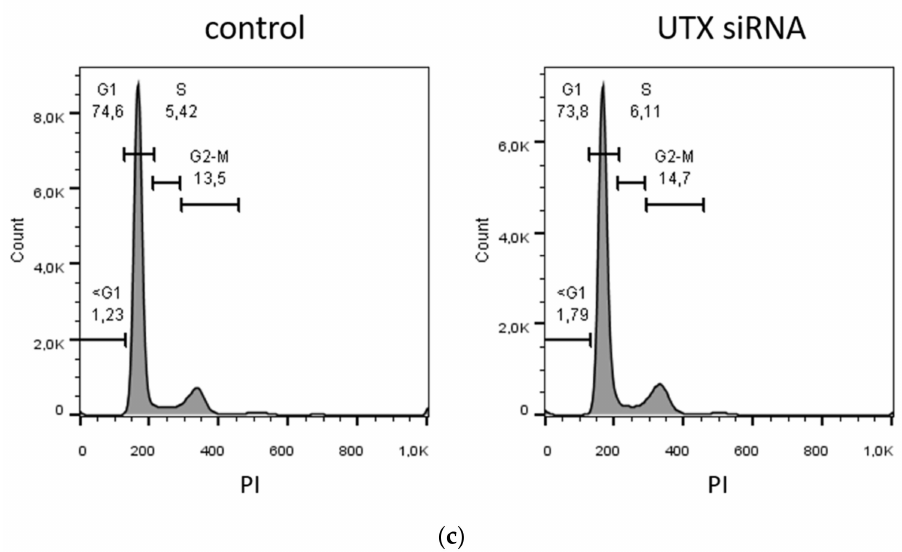
Figure 8. Involvement of p53 in apoptosis induction following UTX knockdown. ( a ) UTX, p53, p21 and MDM2 protein expression in wild-type HBLAK and dominant-negative p53 expressing HBLAK (HBLAK-p53DD) cells 48 h after transfection with UTX siRNA 01. α -Tubulin (TubA) was used as a loading control. As a positive control for p53, p21 and MDM2 expression, VM-CUB-1 cells were used. ( b ) E ff ects of UTX knockdown on morphology in wild-type HBLAK or HBLAK-p53DD cells 3 d after transfection. ( c ) Lack of changes in G1 and sub-G1 fractions in HBLAK-p53DD cells 2